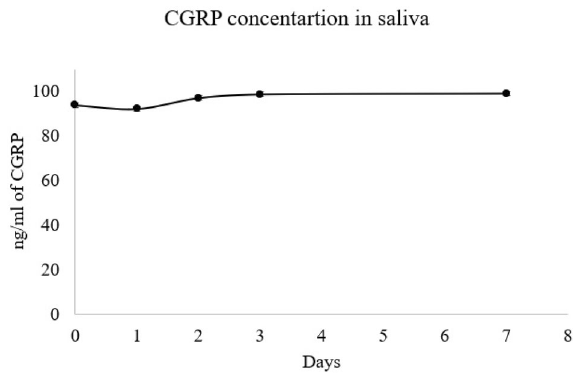
Figure 3. CGRP concentration among the patients at different time